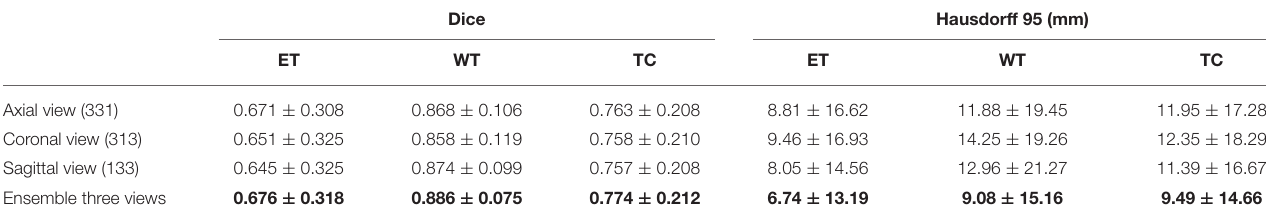
The online evaluation platform computed metrics. The Dice coefficient and Hausdorff distance (mean ± SD) are reported. ET, enhancing tumor, WT, whole tumor, TC, tumor core. Bold values highlight the best results for each metric.